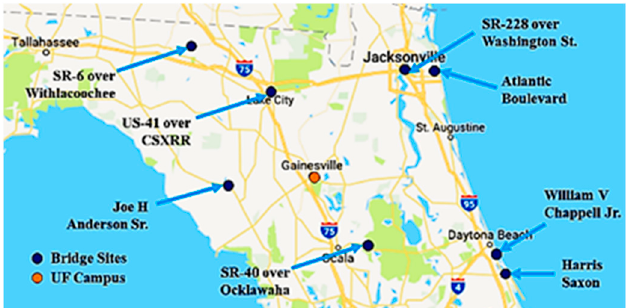
Figure 20. Locations of bridges inspected by UF aircraft (reprinted with permission from Tomiczek,